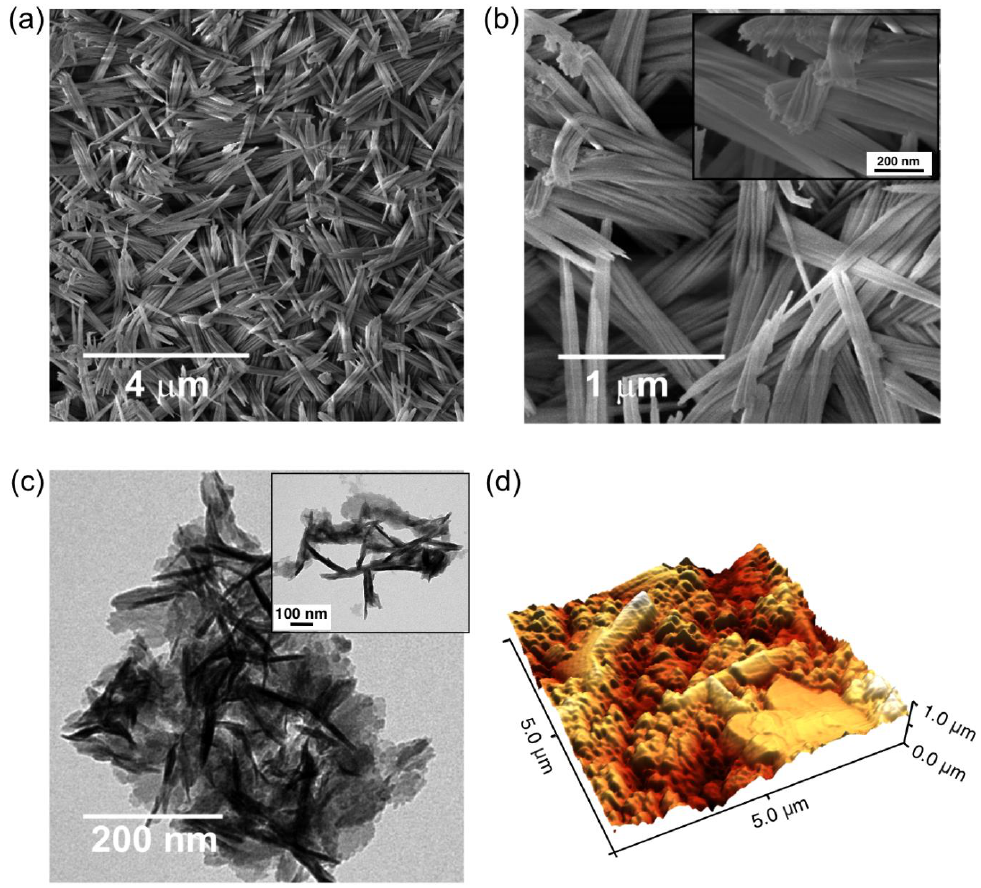
Figure 3. Morphology of anodic CuO/Cu 2 O nanoneedles obtained for Cu foils anodized at 5 ◦ C applying a constant potential of 10 V during 3 min in a 0.1 M KOH + 10% v / v H 2 O electrolyte + 0.1% w / v NH 4 F and dissolved in ethylene glycol film obtained by means of ( a ) and ( b ) FESEM, ( c ) TEM and ( d ) AFM. On the other hand, by decreasing the percentage of water in the electrolyte solution below 10% v / v during anodization, CuO/Cu 2 O or Cu 2 O nanoneedles are obtained on a flake surface and the nanoneedles have a smaller average length as the percentage of water decreases. The Raman spectra of the nanoneedles obtained using 5% v / v water in their synthesis show signals at 146.2, 540.3 and 621.4 cm − 1 , which are characteristic of Cu 2 O, together with the signals at 286.7 and 345.5 cm −1 , which further indicate the presence of CuO in the sample (see Figure 4) [37,52,53,56], whereas, when further reducing the per- centage of water in the synthesis, only characteristic signals for the presence of Cu 2 O in the samples are observed [57]. The formation of these nanostructures is explained by the basic medium in which it is found, since the presence of OH − , H 2 O and ethylene glycol ions tend to the formation of CuO nanostructures from metallic copper (Equation (1)) [38,40,56]. Moreover, the presence of fluoride ions tends to the redissolution of the CuO